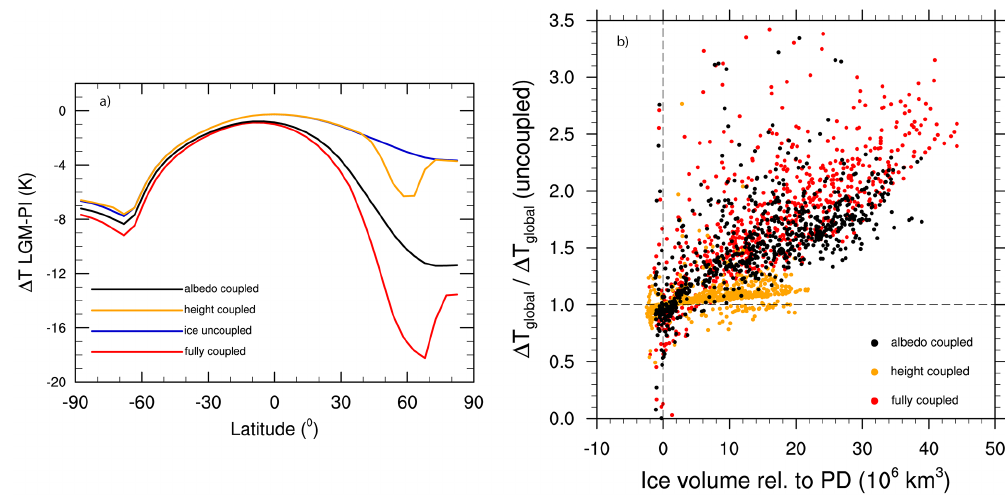
Figure 9. (a) Modelled LGM–PI atmospheric temperature difference, for the same runs as in Fig. 8. (b) Ratio of global temperature anomalies from the fully coupled reference run (red), the height-coupled run (orange) and the albedo-coupled run (black) to those from the ice-uncoupled run, as a function of ice volume in the (partially) coupled run. The temperature data come from the ZEBCM, and the sea level data from the ISM.